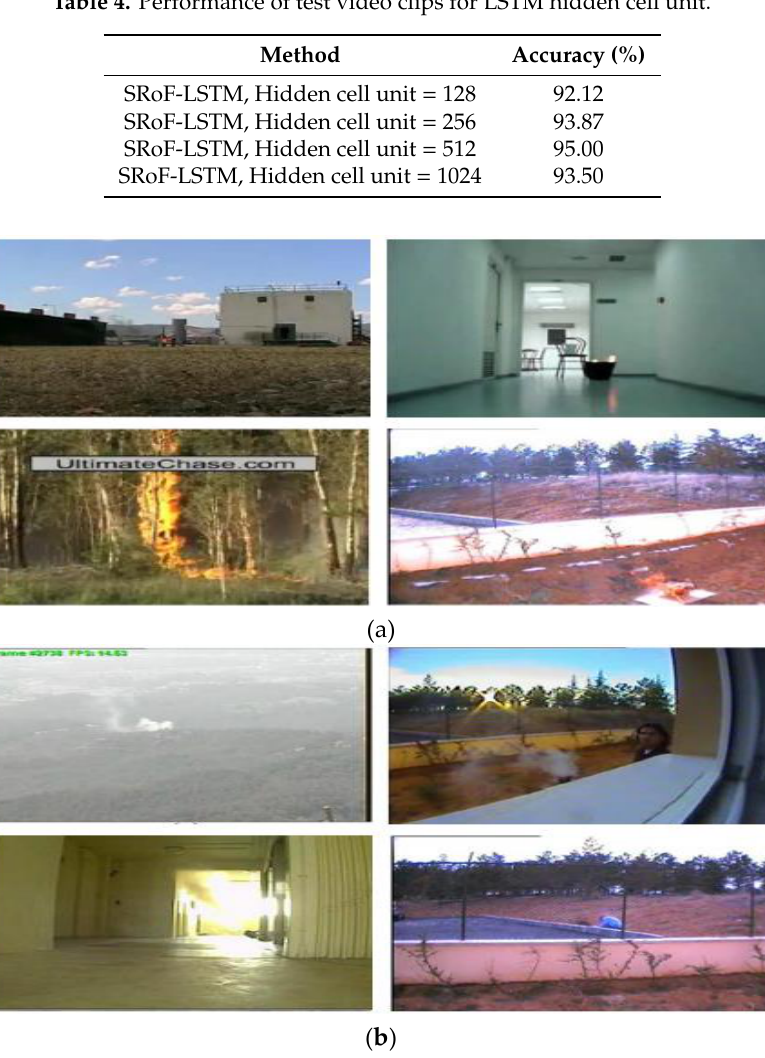
Figure 11. Set of the representative images from Foggia et al. ’s [11] dataset. The ( a ) images are taken from videos of fires, while the ( b ) images are from non-fire videos.